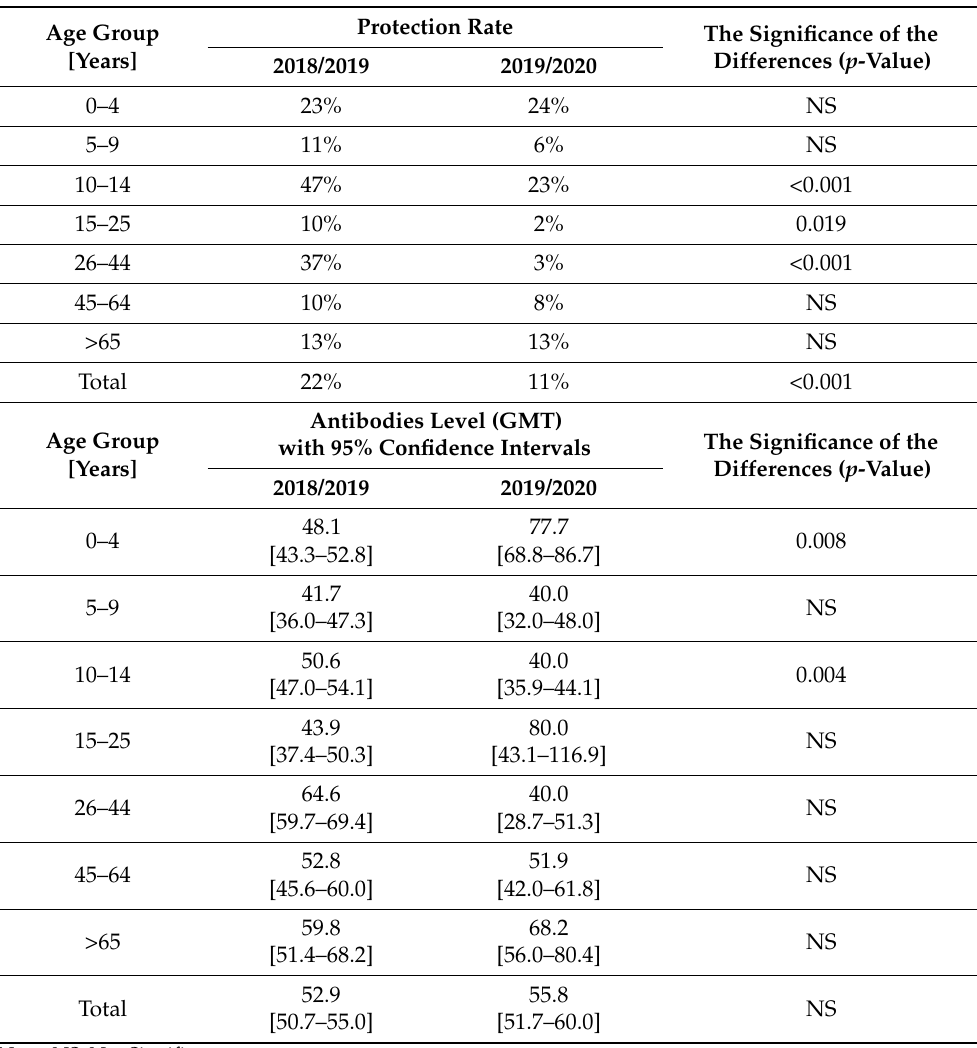
Table 2. Comparison of two past epidemic seasons for B/Colorado/06/2017—Victoria Lineage. Protection Rate The Significance of Age Group [Years]